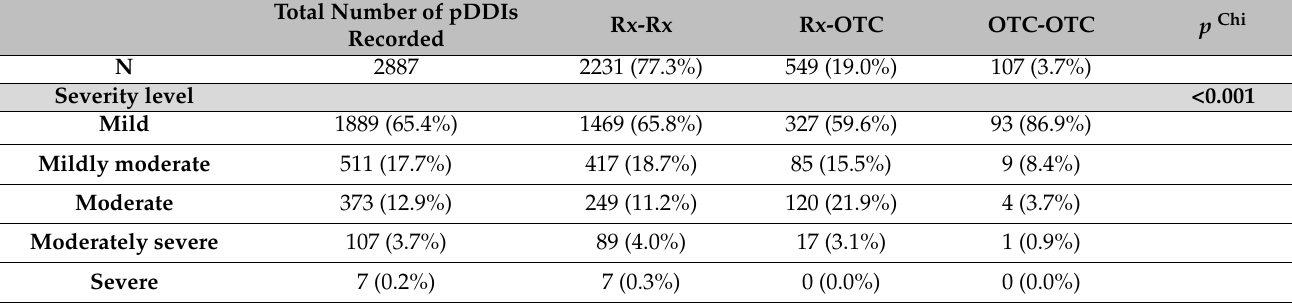
Table 5. Distribution of pDDIs depending on severity level and